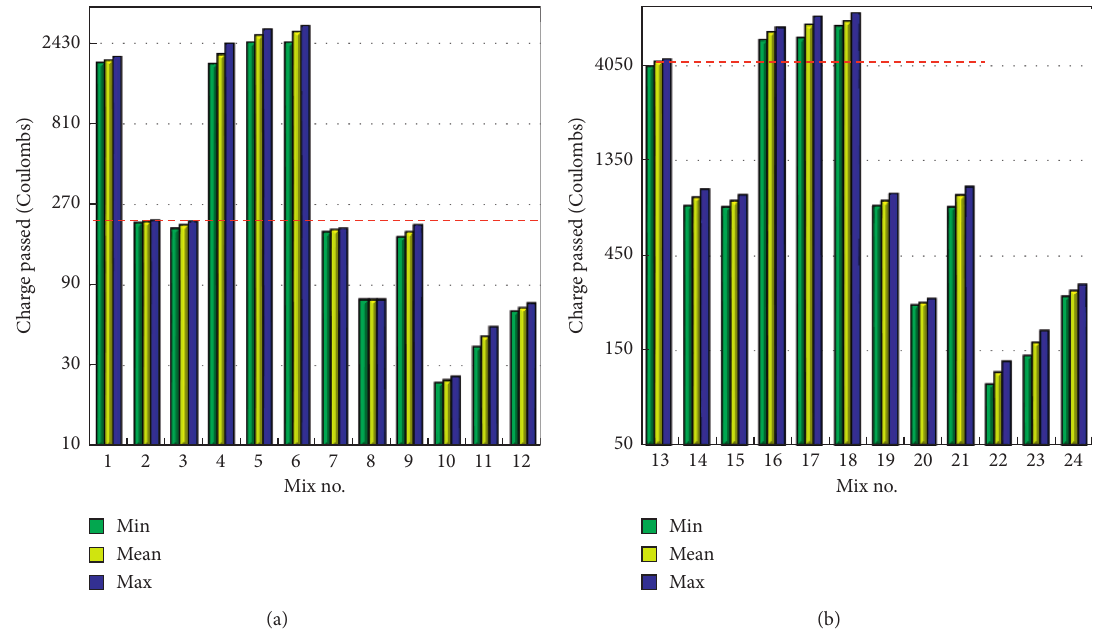
Figure 4: Observed permeability of concrete mixtures that incorporate SF and NP. (a) Batch I ( ( w / b ) � 0.25) and (b) Batch II ( ( w / b ) �